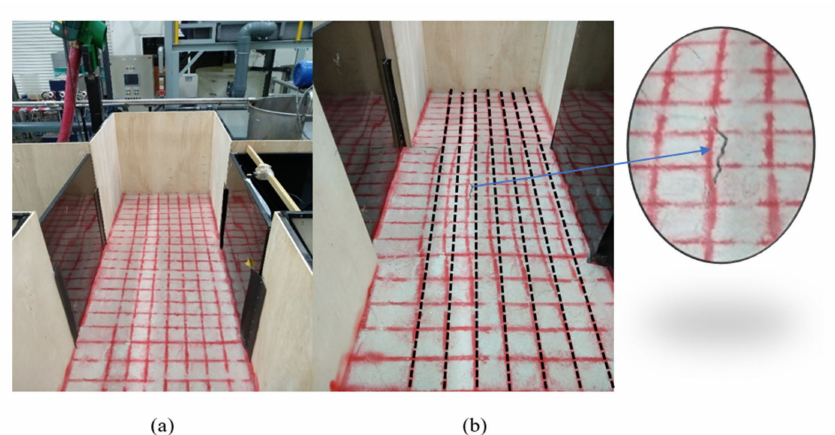
Figure 7. Stages of soil displacement ( a ) initial stage ( b ) at 50 mm displacement. Some initial cracks appeared on the surface of the soil due to the accidental movement of the ground. Most of the cracks at 50 mm were superficial as marked by the brown arrows, and these cracks represent the boundaries of subsidence and heaving of the soil zones (see Figure 8). When the movable plate reached 100 mm, tension cracks appeared in the unstable zone and behind the buried pipe due to increased stress on the pipe. The cracks extended to the stable area (left and right sides) when the plate exceeded 150 mm of movement. The soil surface cracks expanded and widened as the movable plate’s movement increased (see Figure 8, from 200 mm to 700 mm), and these cracks appeared (in both horizontal and vertical directions). Moreover, due to continuing lateral soil displacement towards the buried pipe, numerous cracks were formed along the landslide’s perpendicular direction. After removing the top layer of the backfill at the end of the experiment, the HDPE pipe was in a bent position due to the large lateral soil displacement produced during the test